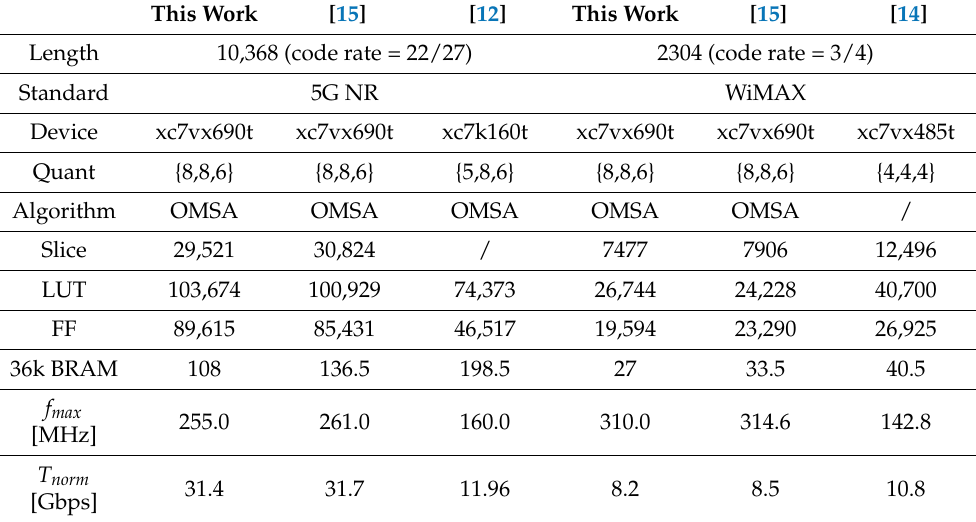
Table 1. Implementation results for 5G NR and WiMAX decoders in comparison with previous works.